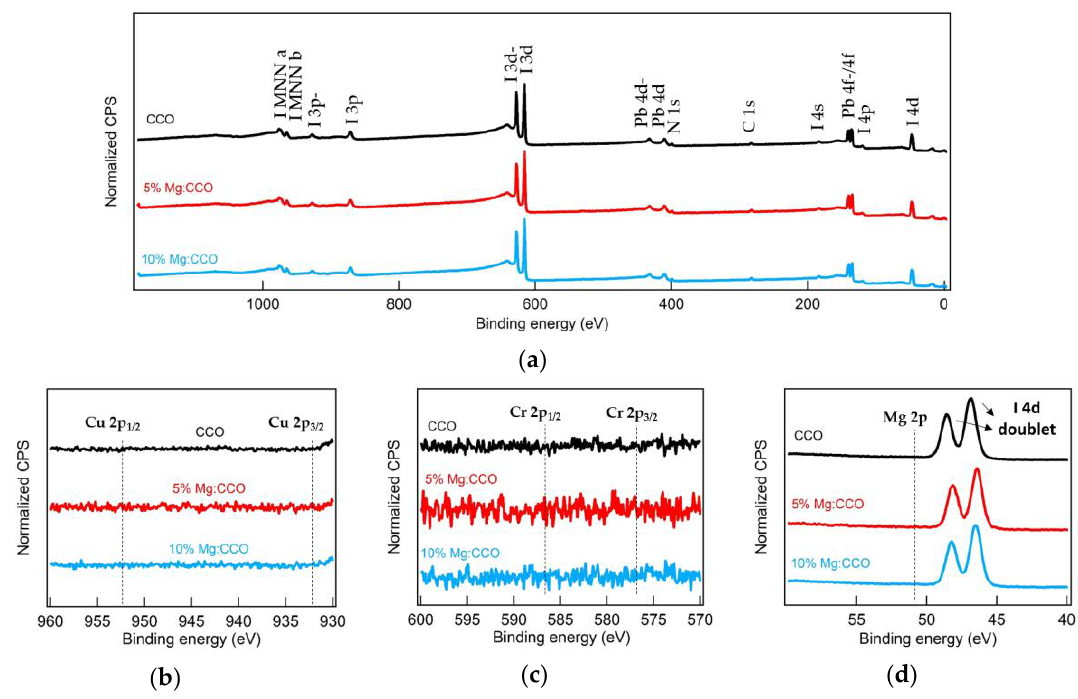
Figure 11. Normalized XPS ( a ) survey, ( b ) Cu 2p, ( c ) Cr 2p, and ( d ) Mg 2p spectra at the surfaces of MAPbI 3 films on top of ITO / HTL. HTLs are CCO (black), 5% Mg:CCO (red), and 10% Mg:CCO (blue). In ( a ), all peaks are indexed by the component elements (C, N, Pb, and I) of MAPbI 3 . In ( b – d ), the dotted lines show binding energies for the Cu 2p, Cr 2p, and Mg 2p core levels of CCO and Mg:CCO. The positions of Cu 2p 1 / 2 , Cu 2p 3 / 2 , Cr 2p 1 / 2 , and Cr 2p 3 / 2 peaks are indexed according to our previous CCO reports [24,27]. The position of Mg 2p peak is indexed according to the report from Hoogewijs et al. [65]. In (d), the peaks correspond to the I 4d orbitals; peaks due to the Mg 2p orbitals are not observed.